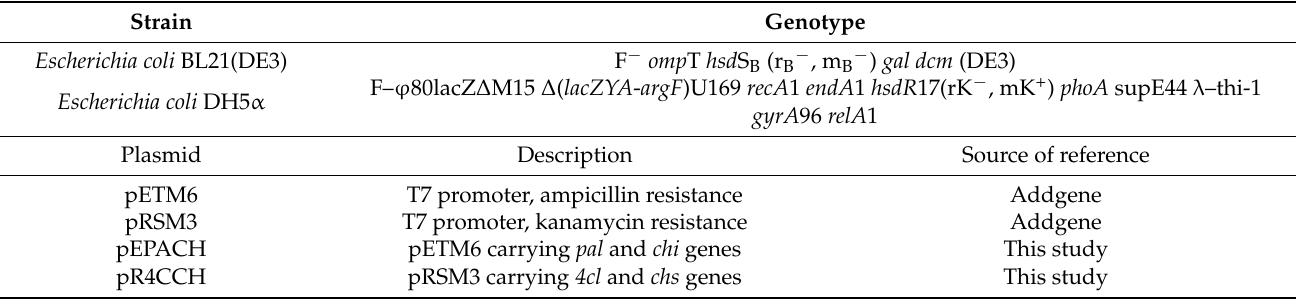
Table 2. Strains and plasmids used in this